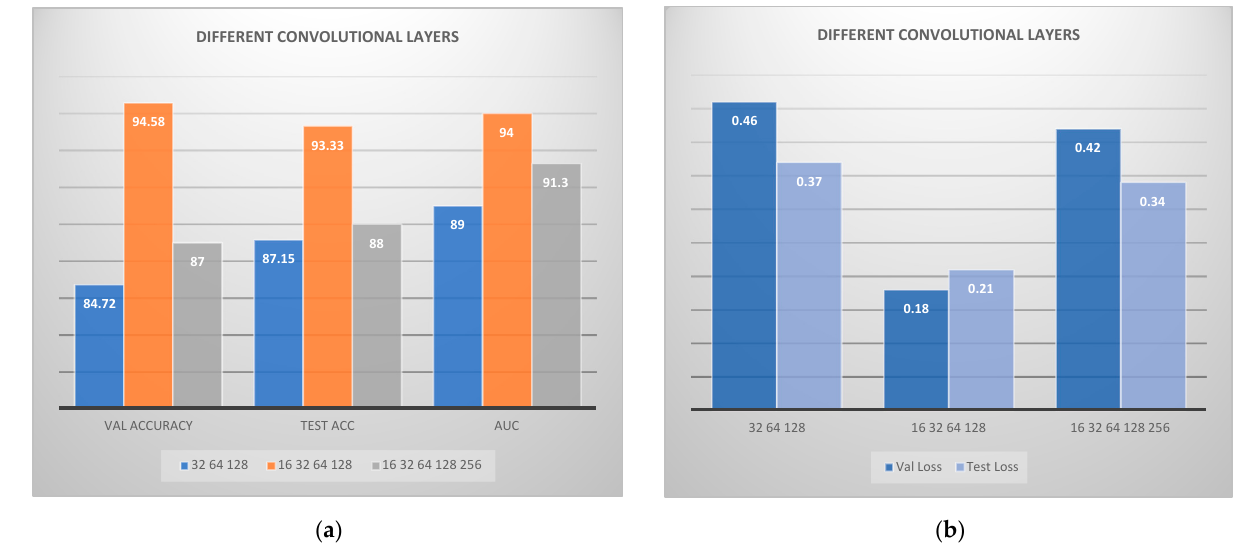
Figure 5. Convolutional neural network architecture for CAD classification problem comparing various convolutional layers: ( a ) accuracies; ( b ) losses. VAL is the validation accuracy and ACC is the accuracy.